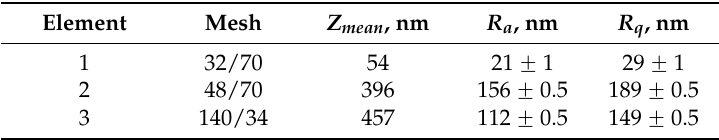
Figure 8. Atomic force microscopy (AFM) 3D view of: ( a ) Element 1 (mesh 32/70); ( b ) Element 2 (mesh 48/70); ( c ) Element 3 (mesh 140/34). Table 2. AFM values of the surface